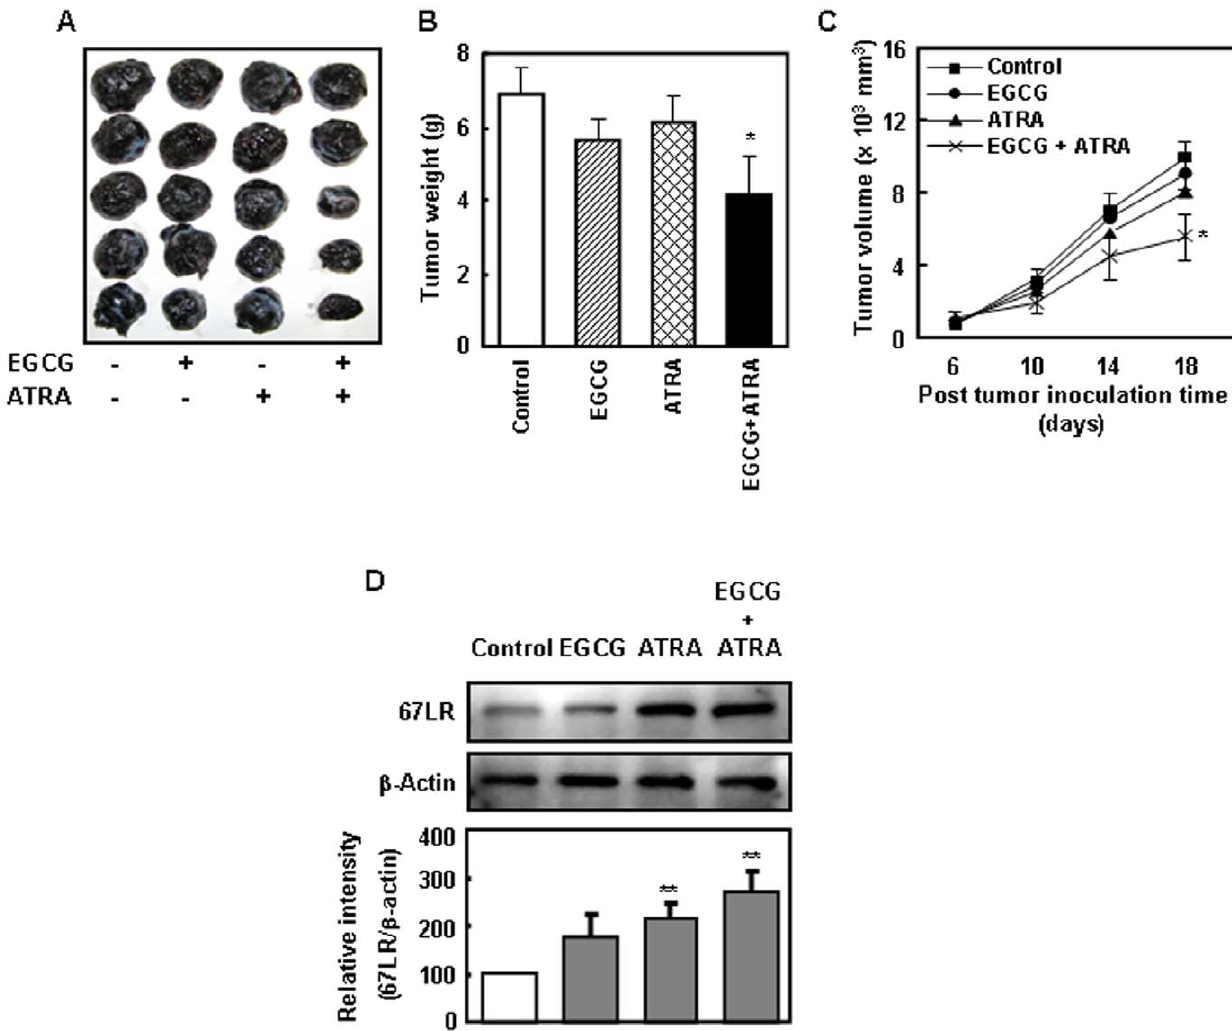
Figure 3. Tumor growth and expression levels of 67LR after the treatment ATRA and EGCG invivo . C57BL/6N mice were subcutaneosly inoculated with B16 cells. The administration of 0.1% EGCG, ATRA (10.5 mg/kg), and combination of EGCG and ATRA was started 1 day before the cell inoculation. A ) We excised tumors from mice 22 days after cell inoculation and photographed them. B ) Tumor weights are represented as the mean 6 S.E. of five mice. Logarithmic transformation for them were analyzed using an one-way ANOVA coupled with a Dunnet test in which * p , 0.05 was the minimum requirement for a statistically significant difference from control group. C ) Tumor volumes was measured in two dimensions and calculated as follows: lengh/2 6 width 2 . Each data point represents the mean 6 S.E. of tumor volumes from five animals and they are significantly different from control group at * p , 0.05 (Mann-Whitney U test). D ) Representative Western blot analyses of 67LR from each individual mouse. Levels of these proteins expression were normalized to b -Actin. Band intensities were quantified using NIH Image J